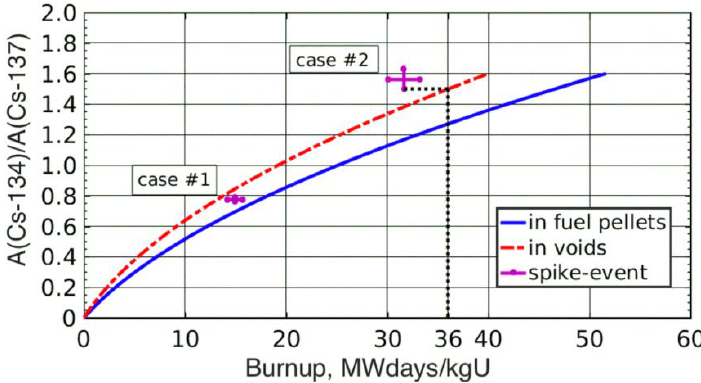
Figure 6. The results of applying the criterion [ 6 ] for evaluation of leaking fuel